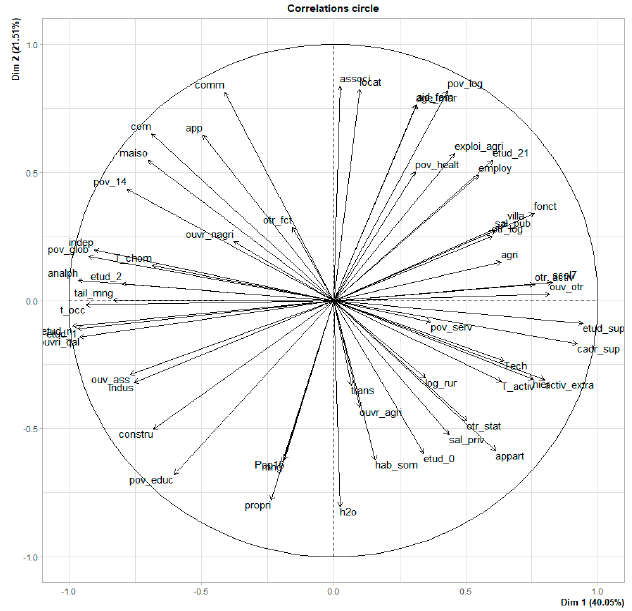
Figure 5. First PCA of variables. Table 1. Summary of the two first components.